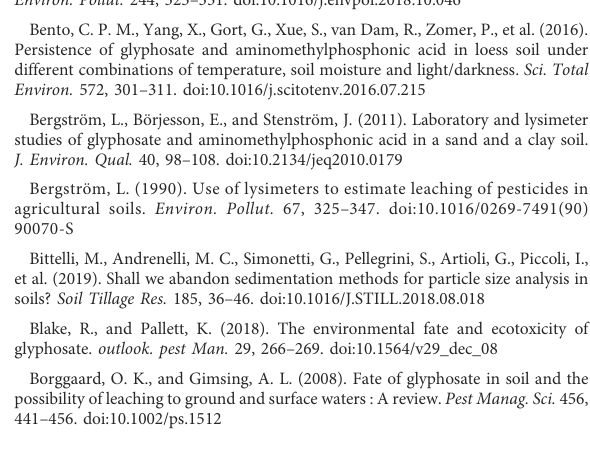
SUPPLEMENTARY FIGURE S1 Glyphosate concentration in μ g L -1 in and out the pore water samplers with the identity line (1:1) as